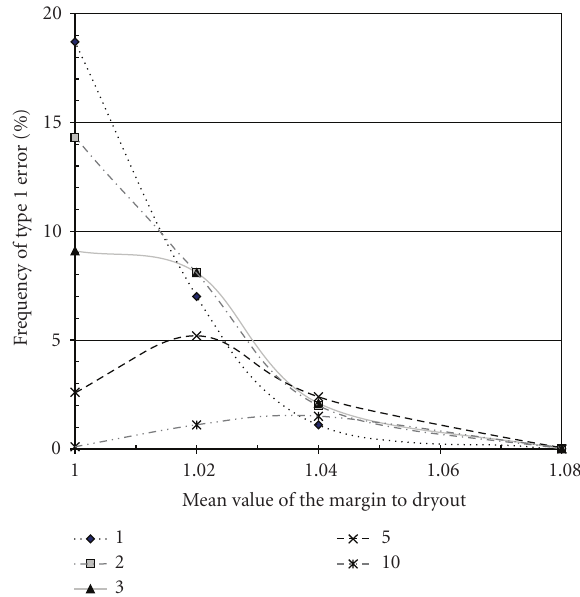
Figure 1: Probability of not predicting dryout when dryout has ac- tually occurred for hypothetical cores with 1, 2, 3, 5, and 10 fuel